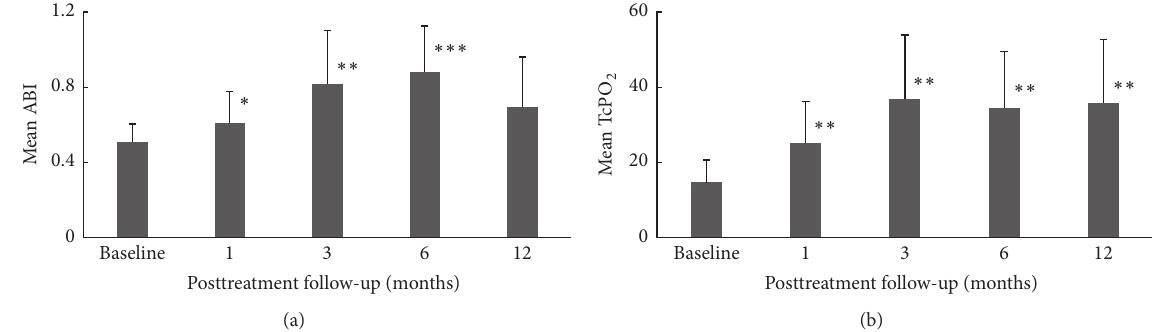
Figure 2: (a) Analysis of changes in ABI from baseline to 12 months ( ∗ 𝑝 < 0.05 ; ∗∗ 𝑝 < 0.01 ; ∗∗∗ 𝑝 < 0.001 ). (b) Analysis of changes in TcPO 2 from baseline to 12 months ( ∗ 𝑝 < 0.05 ; ∗∗ 𝑝 < 0.01 ; ∗∗∗ 𝑝 < 0.001